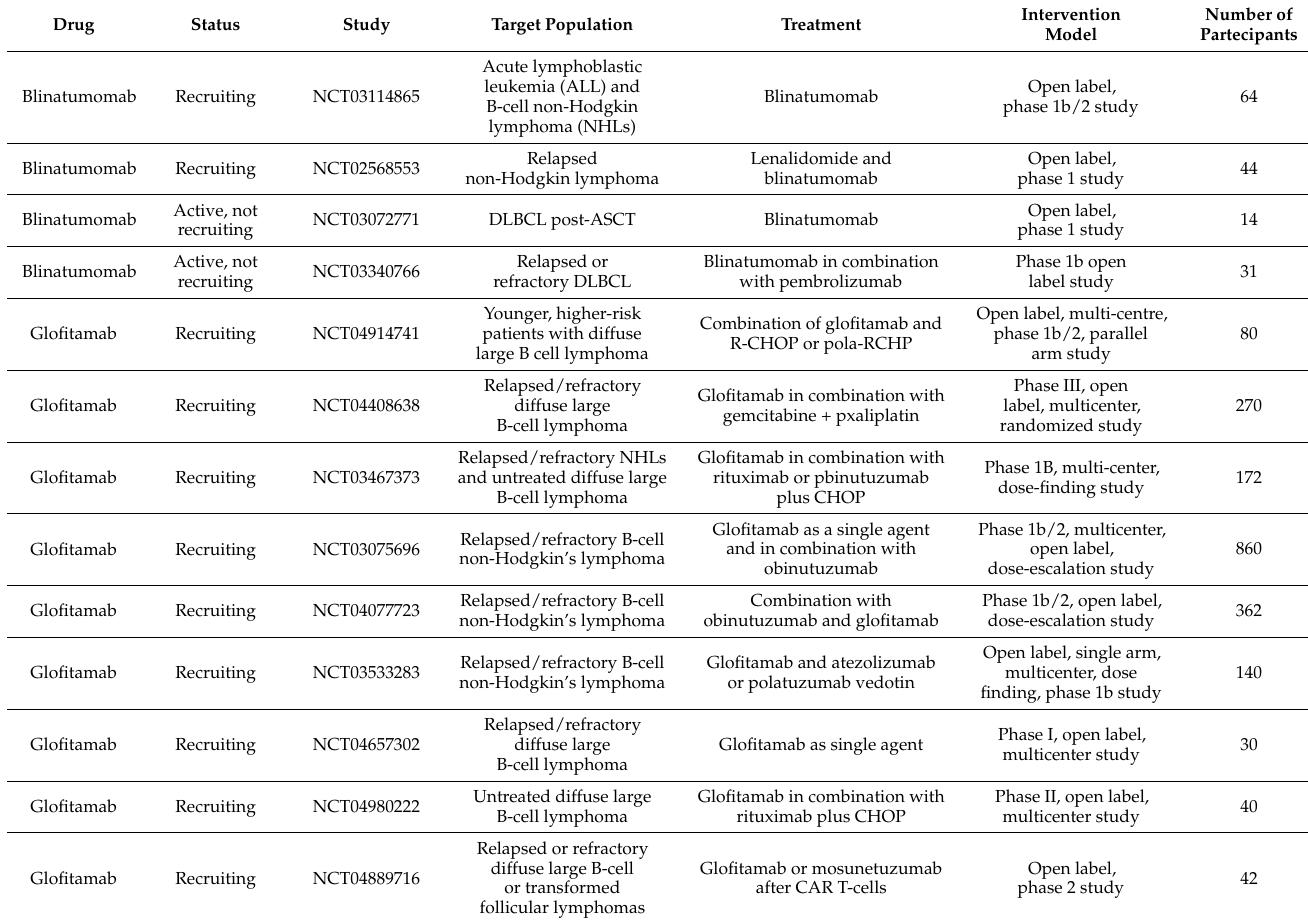
Table 2. Ongoing trials (ClinicalTrial.gov, accessed on 15 October